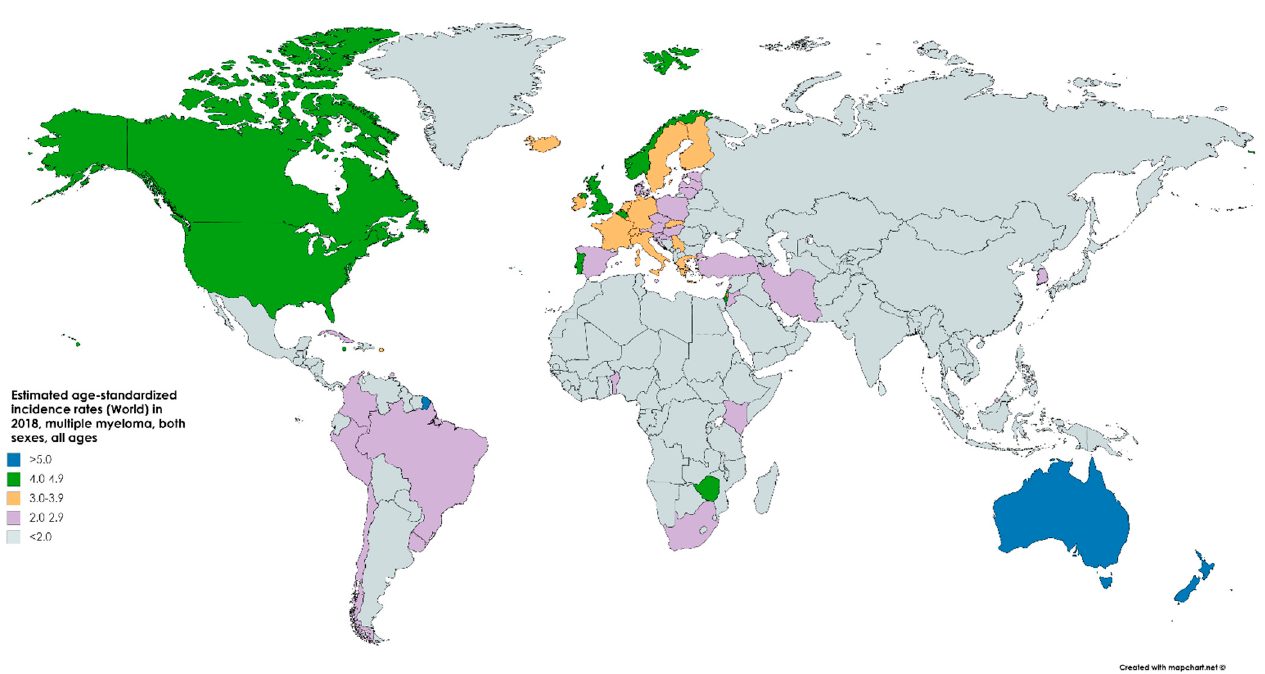
Figure 1. Map showing the estimated age-standardized incidence rates per 100,000 (world) in 2018 of multiple myeloma (MM) for both sexes and all ages. Created with mapchart.net. Data obtained from GLOBOCAN 2018 [7].